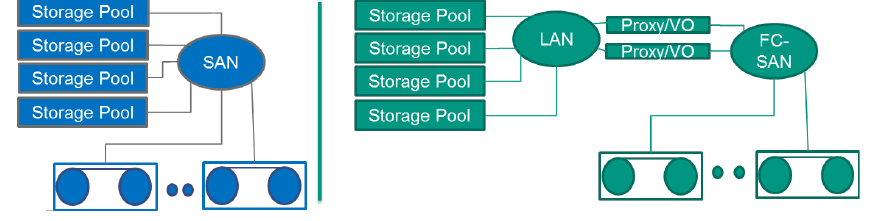
Figure 1: Our previous and current SAN